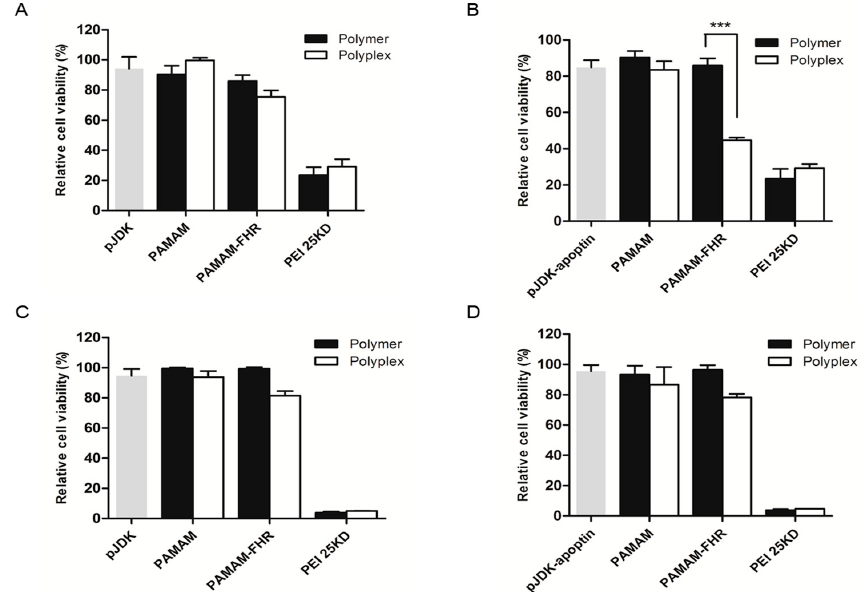
Figure 7. Cytotoxicity induced by PAMAM-FHR/apoptin complexes. ( A , B ) GBL-14 and ( C , D ) dermal fibroblasts were treated with each polymer/pJDK or pJDK-apoptin for 36 h and cytotoxicity was measured using a WST-1 assay. Results are expressed as mean ± standard deviation ( n = 3). Asterisks represent statistically significant values. Unpaired t -test: *** p < 0.001.